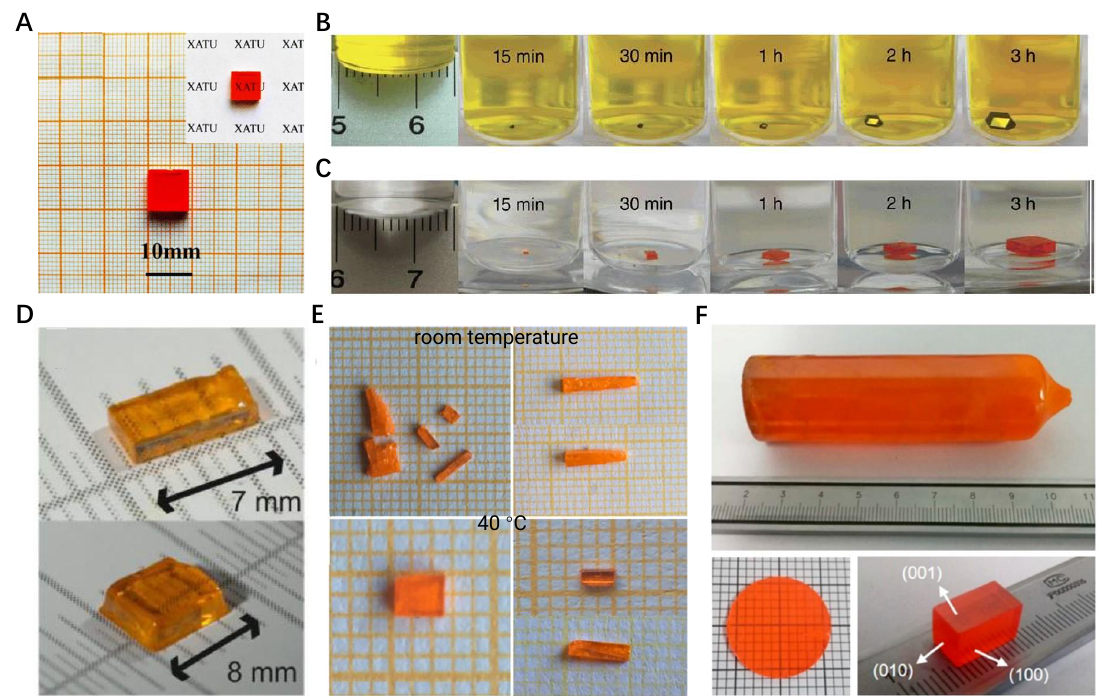
Figure 1. ( A ) Photo of MAPbBr 3 growing after diluting the antisolvent [23]. Copyright 2019, Springer. ( B ) Growth process of MAPbI 3 and ( C ) MAPbBr 3 single crystals from room temperature to 80 ◦ C [25]. Copyright 2015, Nature Publishing Group. ( D ) Photographs of the obtained CsPbBr 3 SCs in the ITC method [30]. Copyright 2016, American Chemical Society. ( E ) Photographs of CsPbBr 3 crystals grown at room temperature and 40 ◦ C in the AVC method, respectively [21]. Copyright 2017, American Chemical Society. ( F ) Photographs of the as − grown CsPbBr 3 crystals in the Bridgman method [31]. Copyright 2018, American Chemical